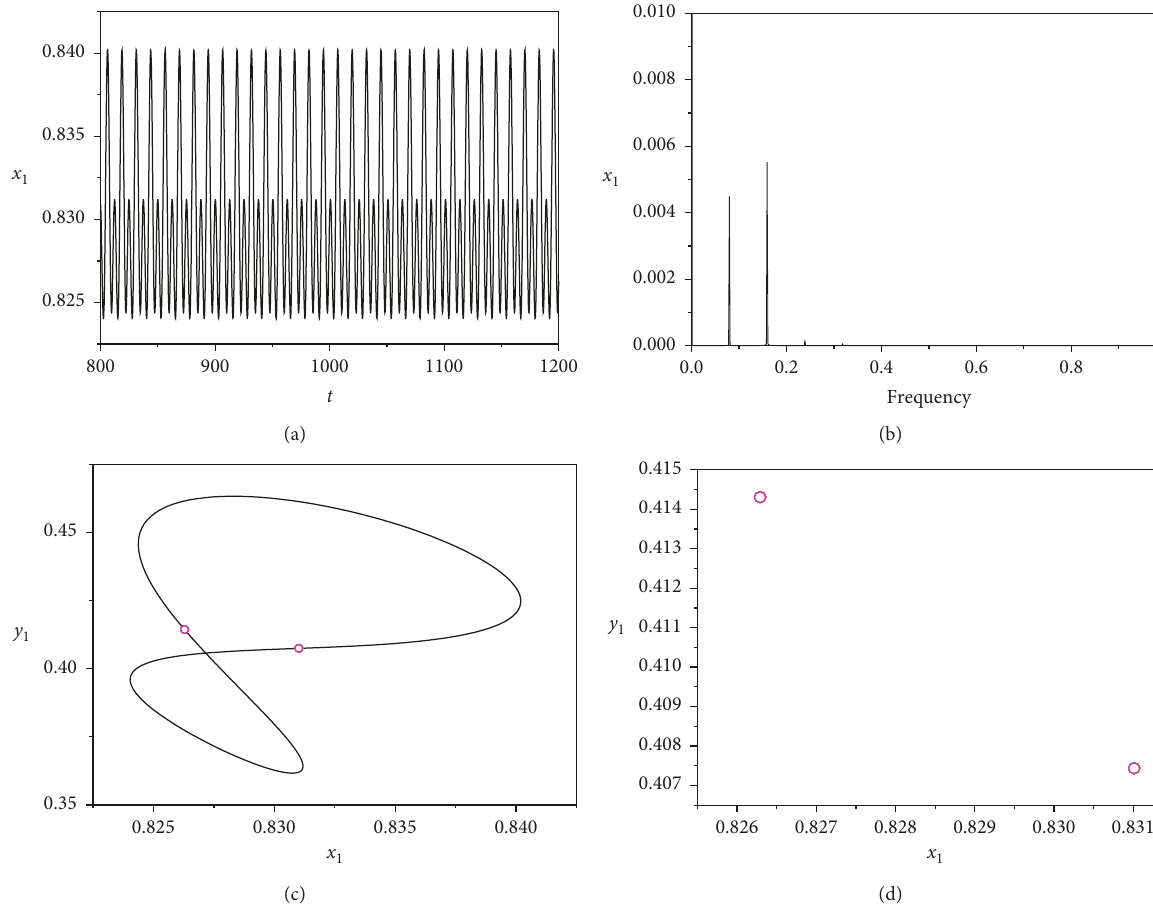
Figure 16: ω � 1.20 and η � 0.50: (a) displacement response; (b) frequency spectrum; (c) rotor orbit; (d) Poincar´e